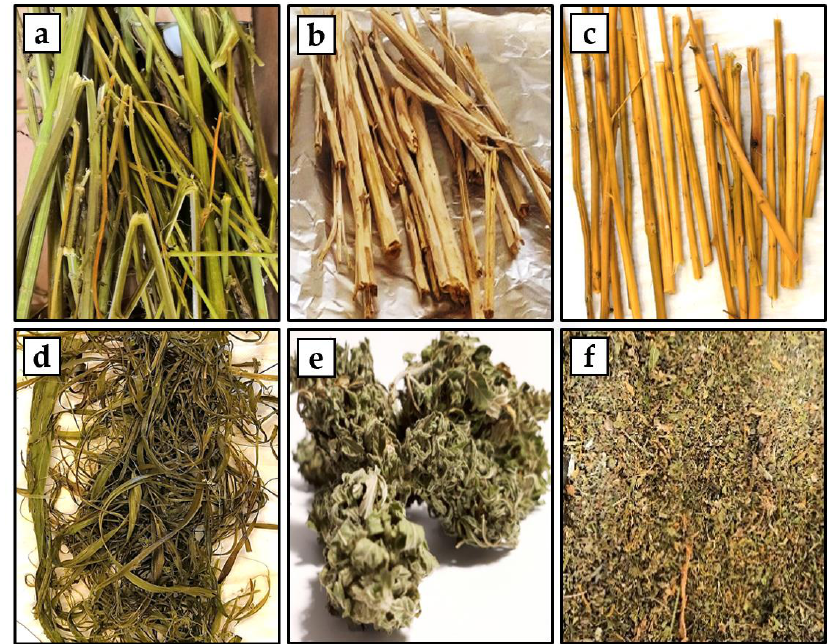
Figure 2. Pictures showing the different HBRs used in this study: stalks ( a ), the unretted hurds ( b ), the retted hurds ( c ), the fibers ( d ), the inflorescences ( e ) and the mix of leaves and inflorescences ( f ).